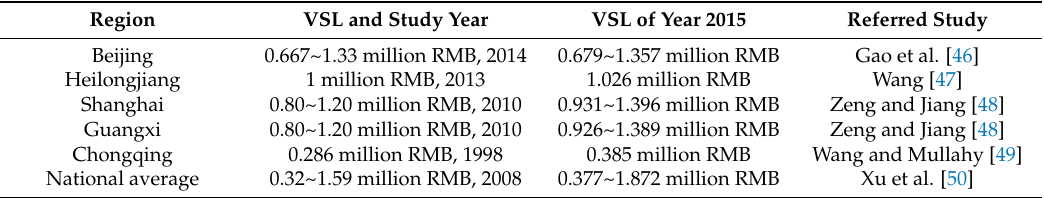
Table 3. The domestic VSL studies and the base year